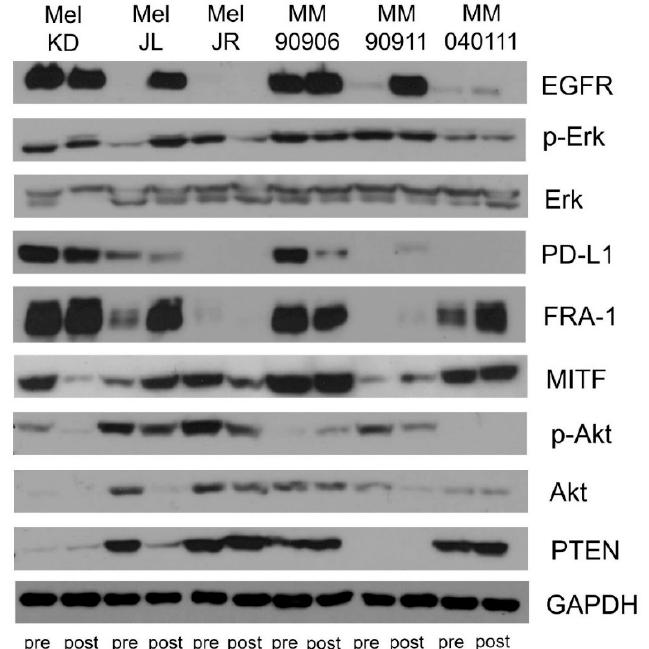
Figure 3. Immunoblot analysis of pErk / Erk, pAkt (Ser473) / Akt, EGFR, MITF, FRA-1, PTEN, PD-L1 expression of the cell line pairs. Blots are representative images from three independent experiments.